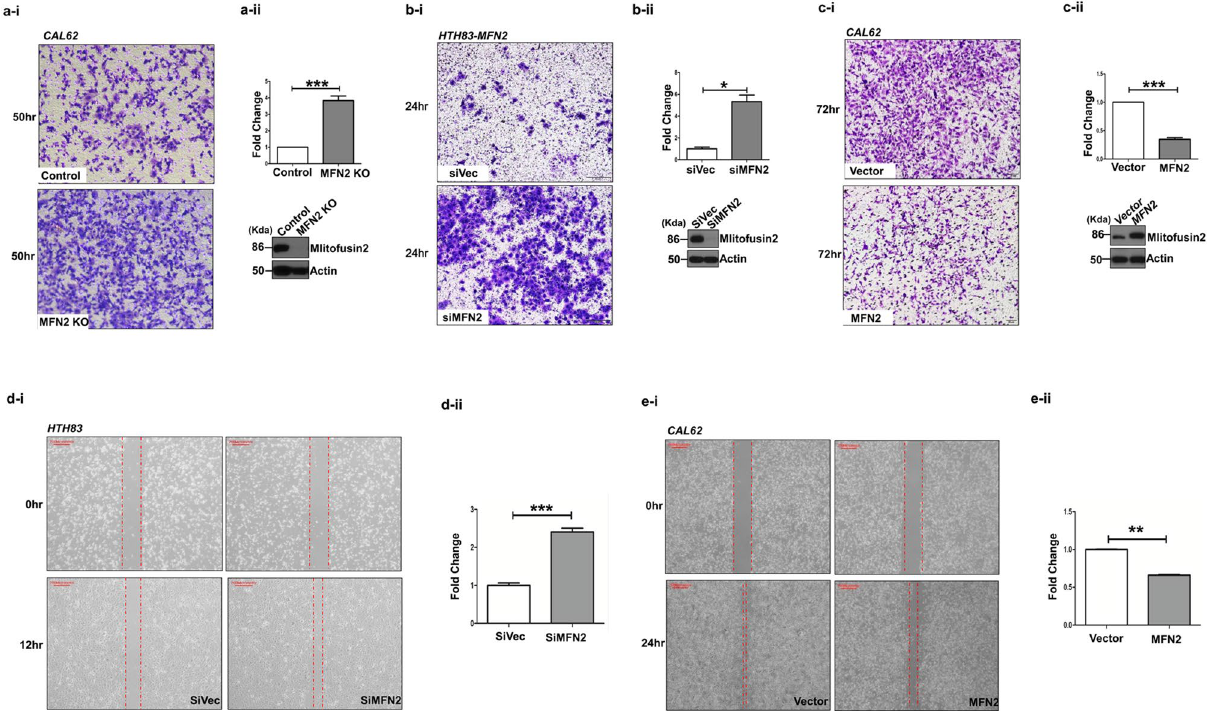
Figure 2. Mitofusin-2 inhibits migration and invasion ability of Cal62 and HTH83 cancer cells. ( a-i ) Transwell assays were performed in the Cal62 control and MFN2 KO groups. A representative image was obtained from an image dyed 50 h after the initial seeding (pore size 0.4 μm). The image was acquired at a magnification of ×100; scale bar represents 50 μm. ( a-ii ) Graph of the quantified results of ( a-i ). Significantly more cells migrated in the MFN2 KO group than those in the control group. ( b-i ) Transwell assays were performed in the HTH83 siVector and siMFN2 groups. A representative image was acquired 24 h after the initial seeding (pore size 0.8 μm). The image was acquired at a magnification of ×100; scale bar represents 50 μm. ( b-ii ) Graph of the quantified results of ( b-i ). Significantly more cells migrated in the siMFN2 group (HTH83 MFN2 cell line) than those in the si Vector group. ( c-i ) Transwell assays were also performed in the Cal62 Vector and MFN2 overexpression groups. A representative image was acquired 72 h after the initial seeding (pore size 0.4 μm). The image was acquired at a magnification of ×100; scale bar represents 50 μm. ( c-ii ) Graph of the quantified results of ( c-i ). Significantly fewer cells migrated in the MFN2 overexpression group than those in the control group. ( d-i ) Wound-healing assays were also performed in the HTH83 siVector and HTH83 siMFN2 groups using the HTH83 MFN2 cell line. We measured the gap distance 12 h after the initial scratching. ( d-ii ) Quantification of the results of ( d-i ) compared to the initial scratch size of the first gap distance after 12 h. ( e-i ) Wound-healing assays were performed to investigate the differences between the Cal62 control and Cal62 MFN2 KO groups. We measured the gap distance 9 h after the initial scratching. ( e-ii ) Quantification of the results of ( e-i ) compared to the initial scratch size of the first gap distance after 9 h. Asterisks (p < 0.05 [*], p < 0.01 [**], p < 0.001 [***]) indicate significant differences in the statistical analyses. Each data point represents the mean ± standard error of three independent